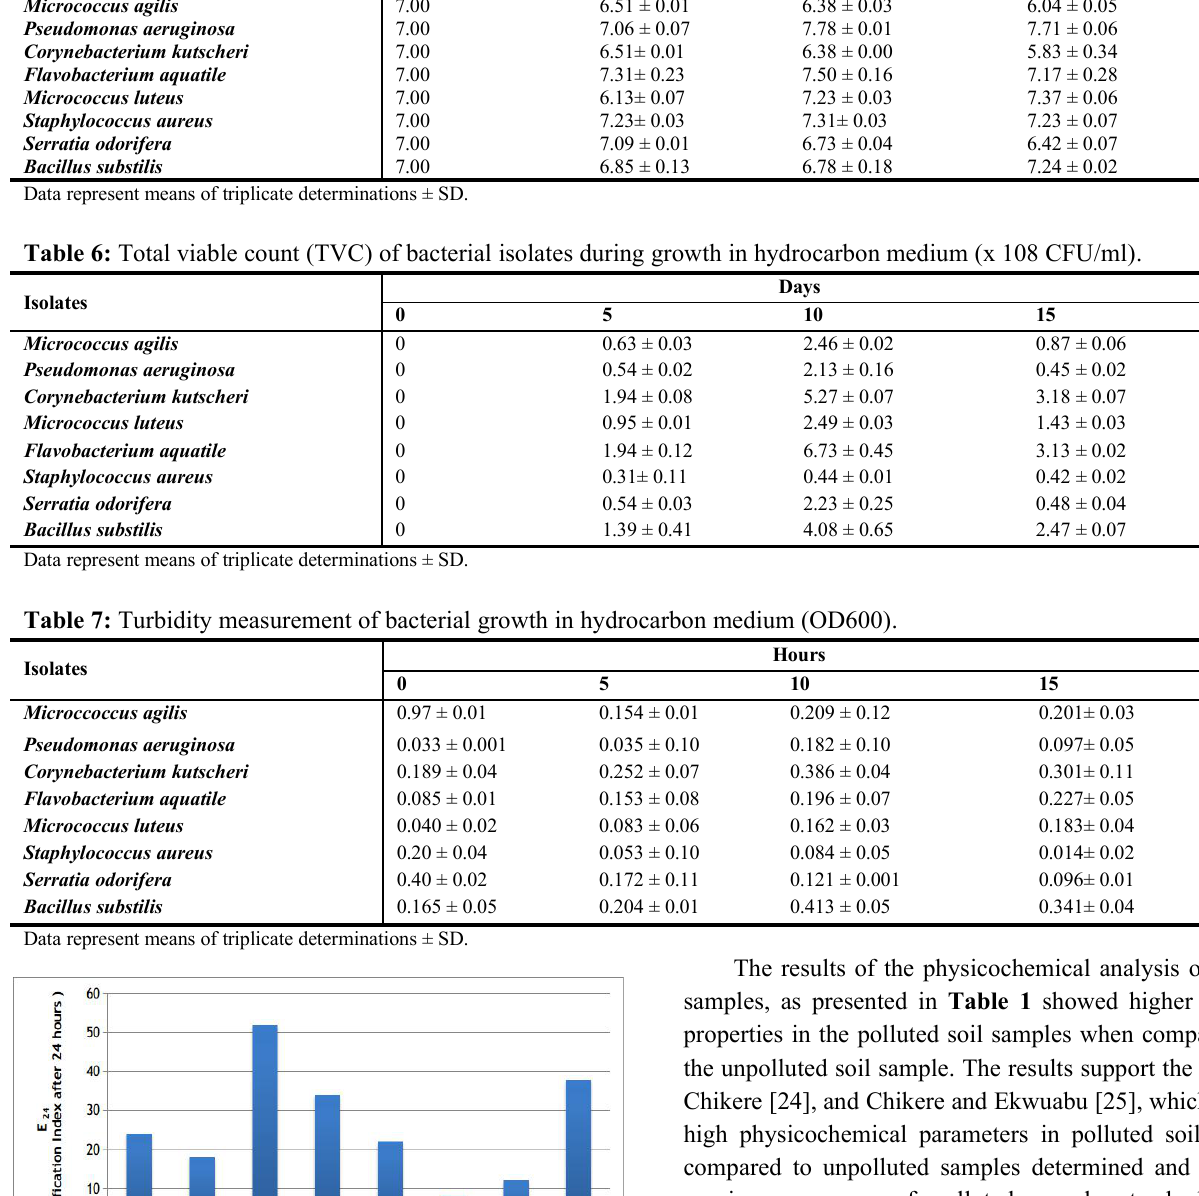
Table 5 : pH of the medium during the growth of bacterial isolates in hydrocarbon medium. Isolates